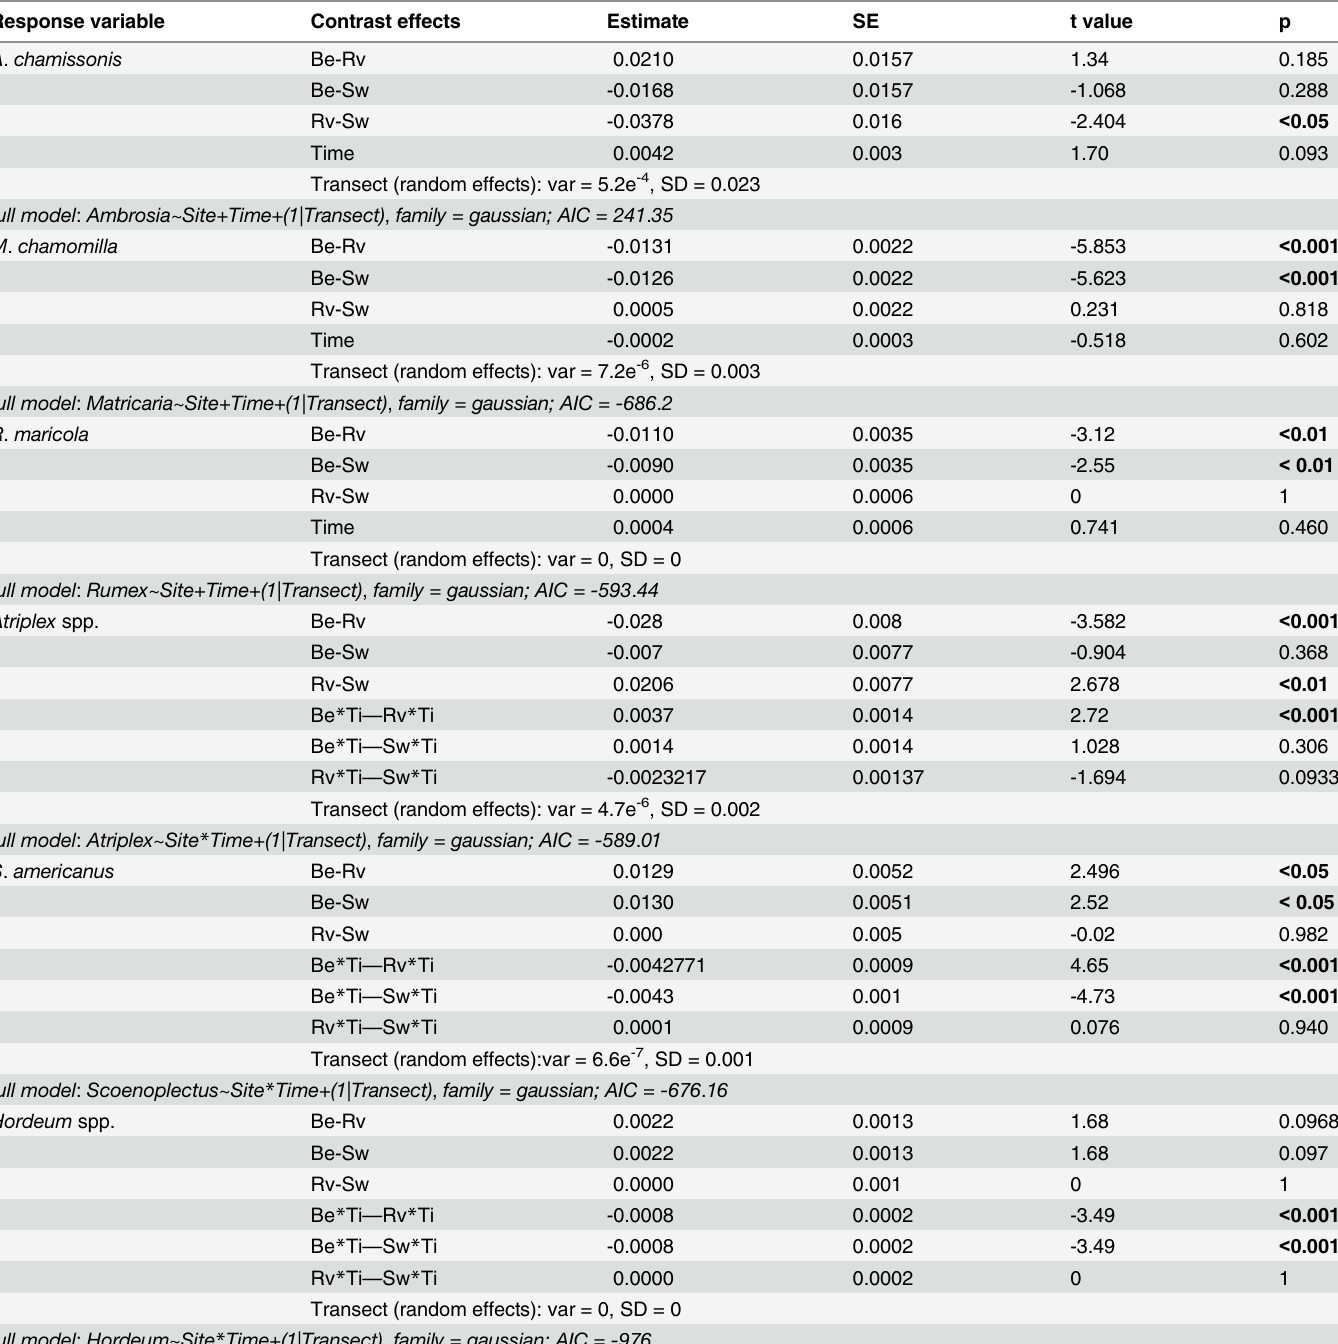
Table 2. Results of GLMMs (model fit by maximum likelihood, Laplace approximation) containing pair-wise contrasts for the main plant species (standardized absolute cover, see Methods) of the vegetated area at each study site. Response